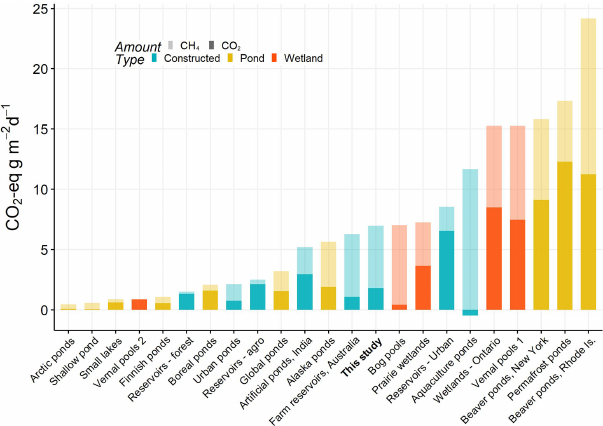
Figure 6. Total average CO 2 equivalent fluxes of CO 2 and CH 4 (diffusive) measured in natural and artificial small waterbodies ( < 0 . 01km 2 ). CO 2 -e fluxes were calculated based on 100-year sustained-flux global warming potentials in Neubauer and Megoni- gal (2015). Relative proportions of each gas are indicated by shad- ing, and waterbody type is given by colour. All data are from the published literature and references can be found in the Table